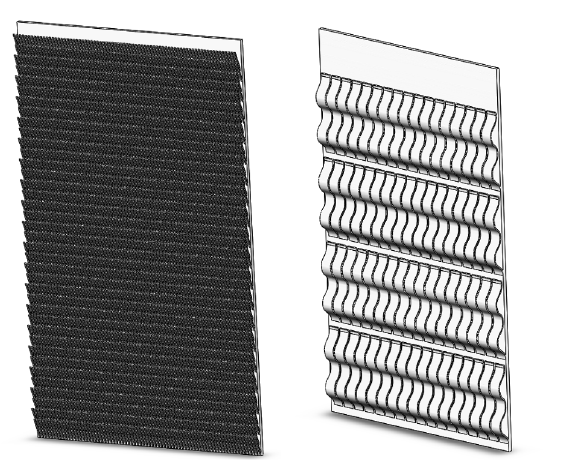
Figure 2. Candidate spring-like structures to enhance heat transfer between the cladding wall (shown) and fuel form (not shown).